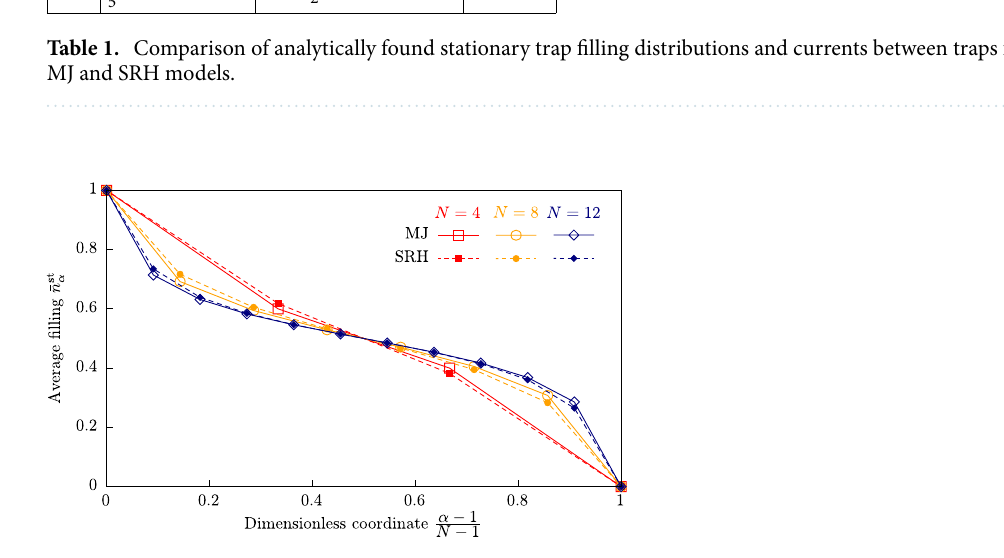
Figure 5. Trap filling distributions, calculated in terms of SRH and MJ approaches for N = 4 , 8 and